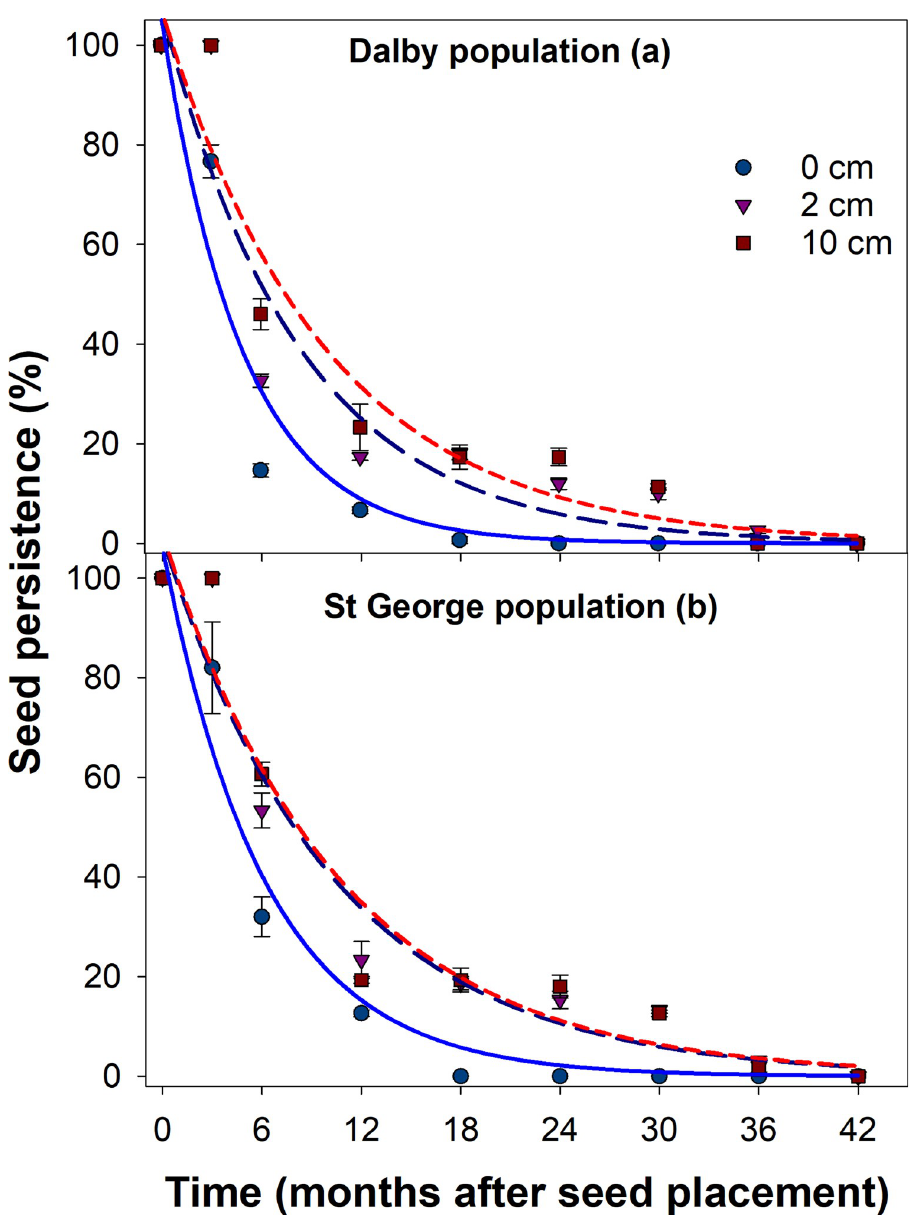
Fig 5. Effect of burial depth and burial duration on seed persistence (%) of two populations [Dalby (a) and St George (b)] of Urochloa panicoides . Bars are the standard error of means (n = 3). The curves represent an exponential decay model (red, 0 cm; yellow, 2 cm; and blue, 10 cm) and parameter estimates of the model are shown in Table